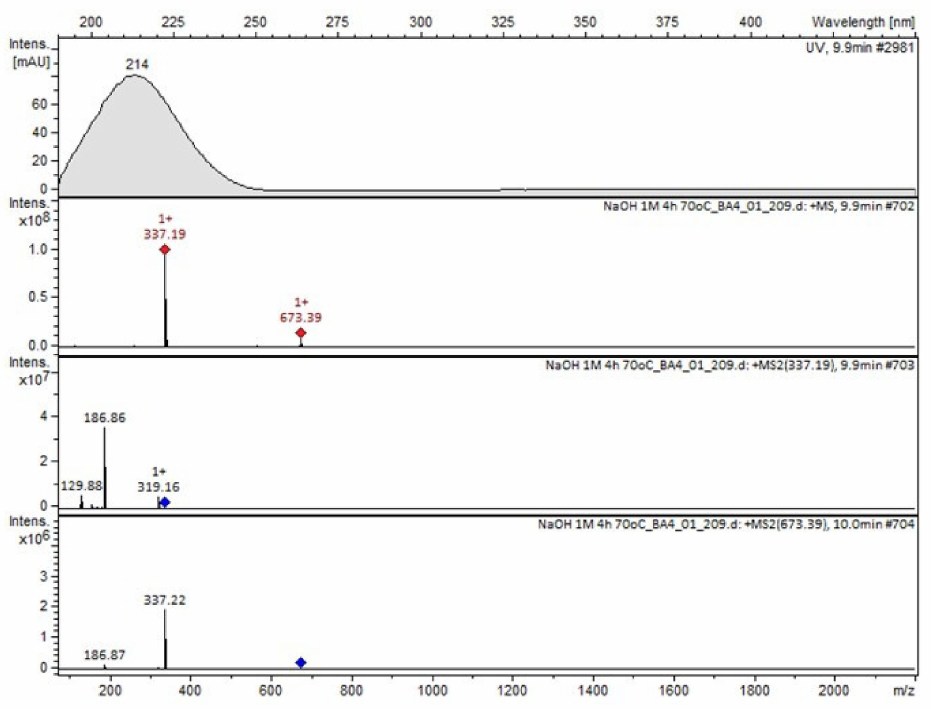
Figure 9. MS and UV/VIS spectra of Compound